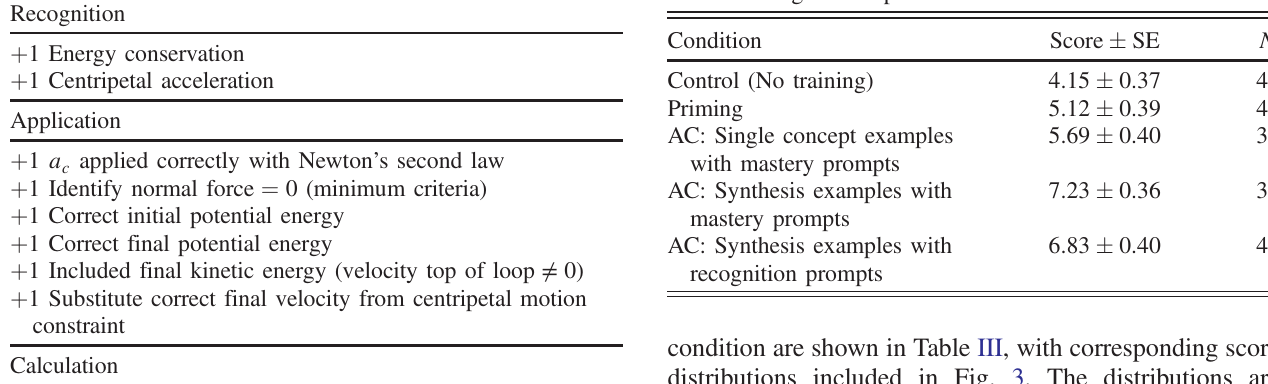
TABLE III. Mean score on target synthesis problem out of a maximumscoreof9pointsbycondition.Errorsshownarestandard errors. Analogical comparison conditions are labeled